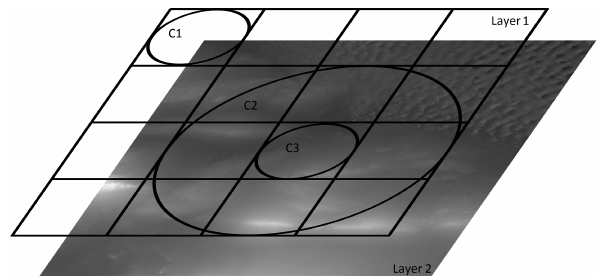
Figure 1. Diagram of the relationships among a Lebesgue measure, scale and geophysical